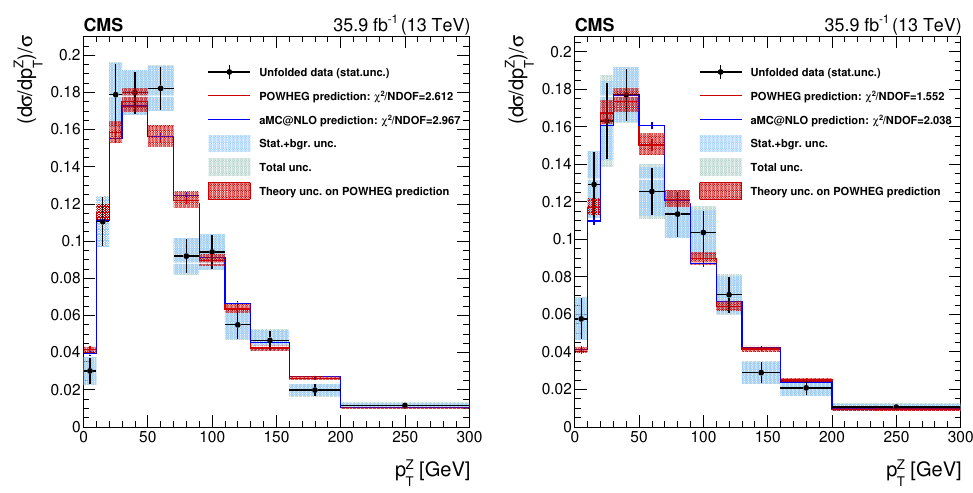
Figure 12 . Di(cid:11)erential distributions for W + (left) and W (cid:0) (right), in the full SR. The transverse momentum of the Z boson is unfolded at the dressed leptons level, as described in the text. The red band around the powheg prediction represents the theory uncertainty in it; the e(cid:11)ect on the unfolded data of this uncertainty, through the unfolding matrix, is included in the shaded bands described in the legend.